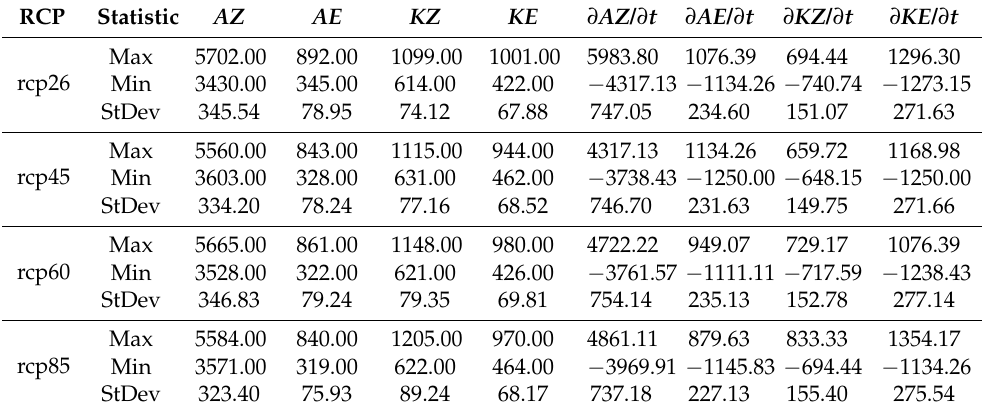
Table 1. Energy forms and their rates of change. Units: energies in 10 3 Jm − 2 , rates of change in 10 − 3 Wm − 2 .